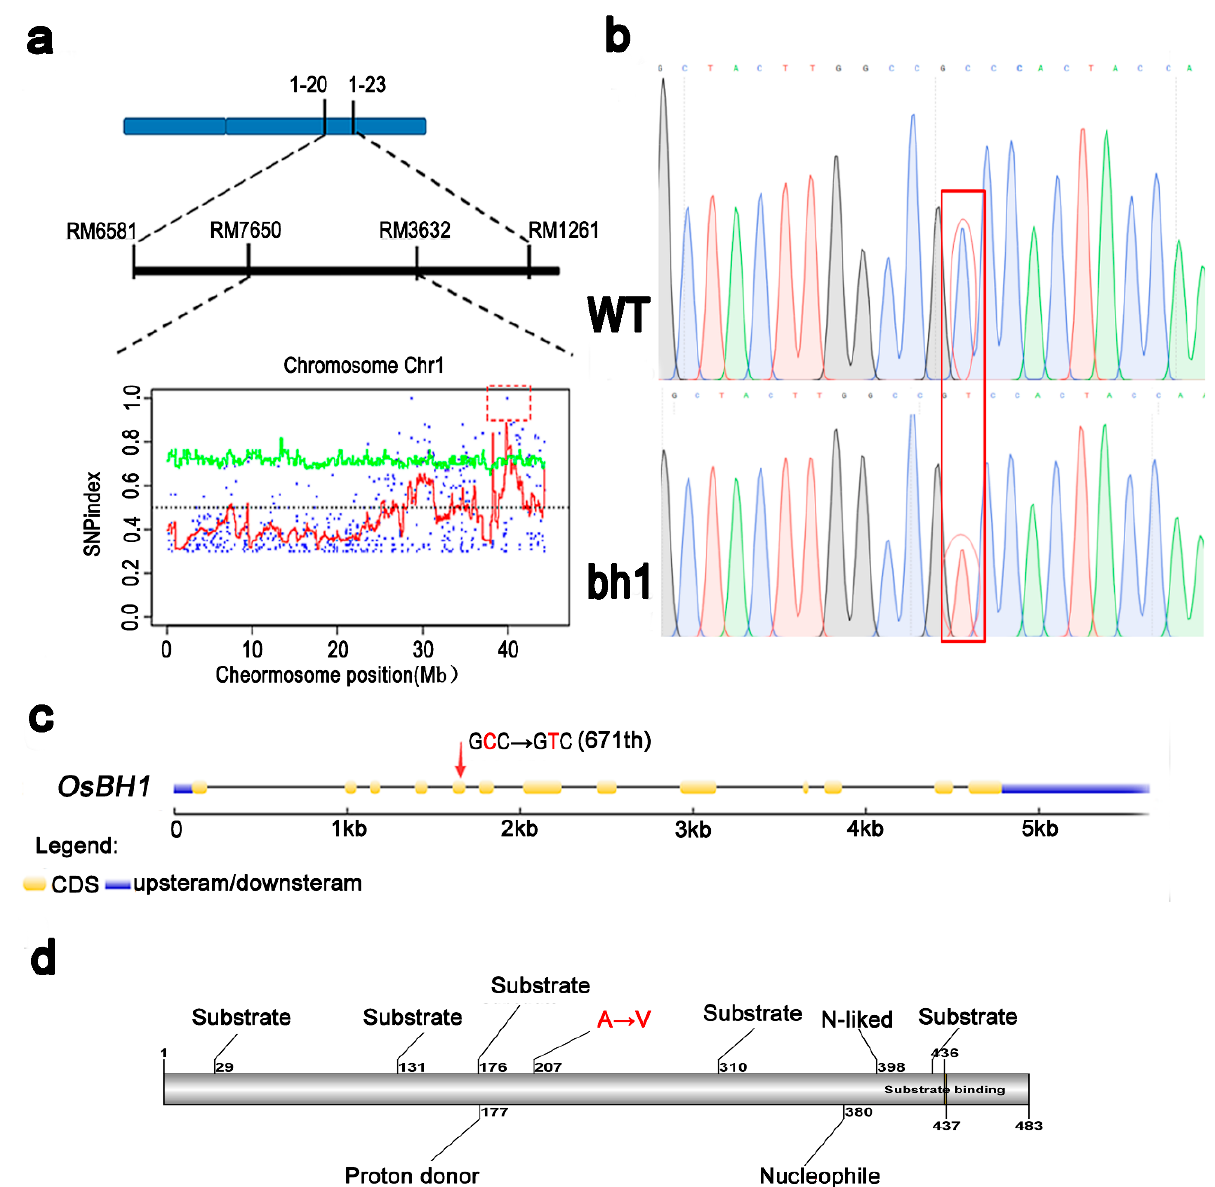
Figure 4. Primary mapping and the Mutmap assay of (brown hull1) bh1. ( a ) SSR marker and MutMap assays, ( b ) Chromatogram showing the position of SNP in bh1 ( c ) Gene structure analysis, ( d ) protein structure analysis, where ( c ) the SNP and ( d ) the amino acid site are highlighted in red.